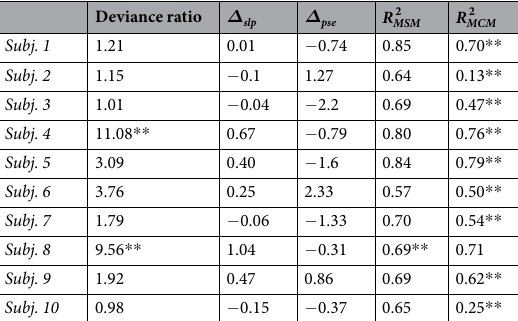
Table 2. Perceptual synergies. The deviance ratio measures the relation between the deviances obtained by fitting the psychometric and the synergy curve on the probabilities of the ‘yes’ answer. Deviance ratio not exceeding χ ² critical value with 2 degrees of freedom ( ** for p < 0.01) indicates that synergy curve describes perceptual behavior no worse than the psychometric function. Δ slp and Δ pse were obtained by subtracting 2 values quantify synergy curve parameters from those describing the psychometric function. Efron pseudo- R MSM 2 distribution is significantly different than those associated (p < 0.01) assessing whether the median of the R MCM